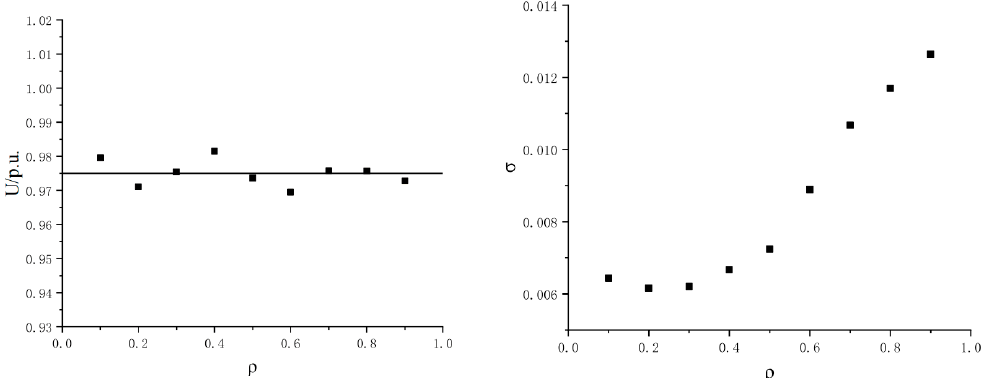
Figure 8. E ff ect of wind speed correlation of node 30 on voltage Figure 8. Effect of wind speed correlation of node 30 on voltage amplitude.